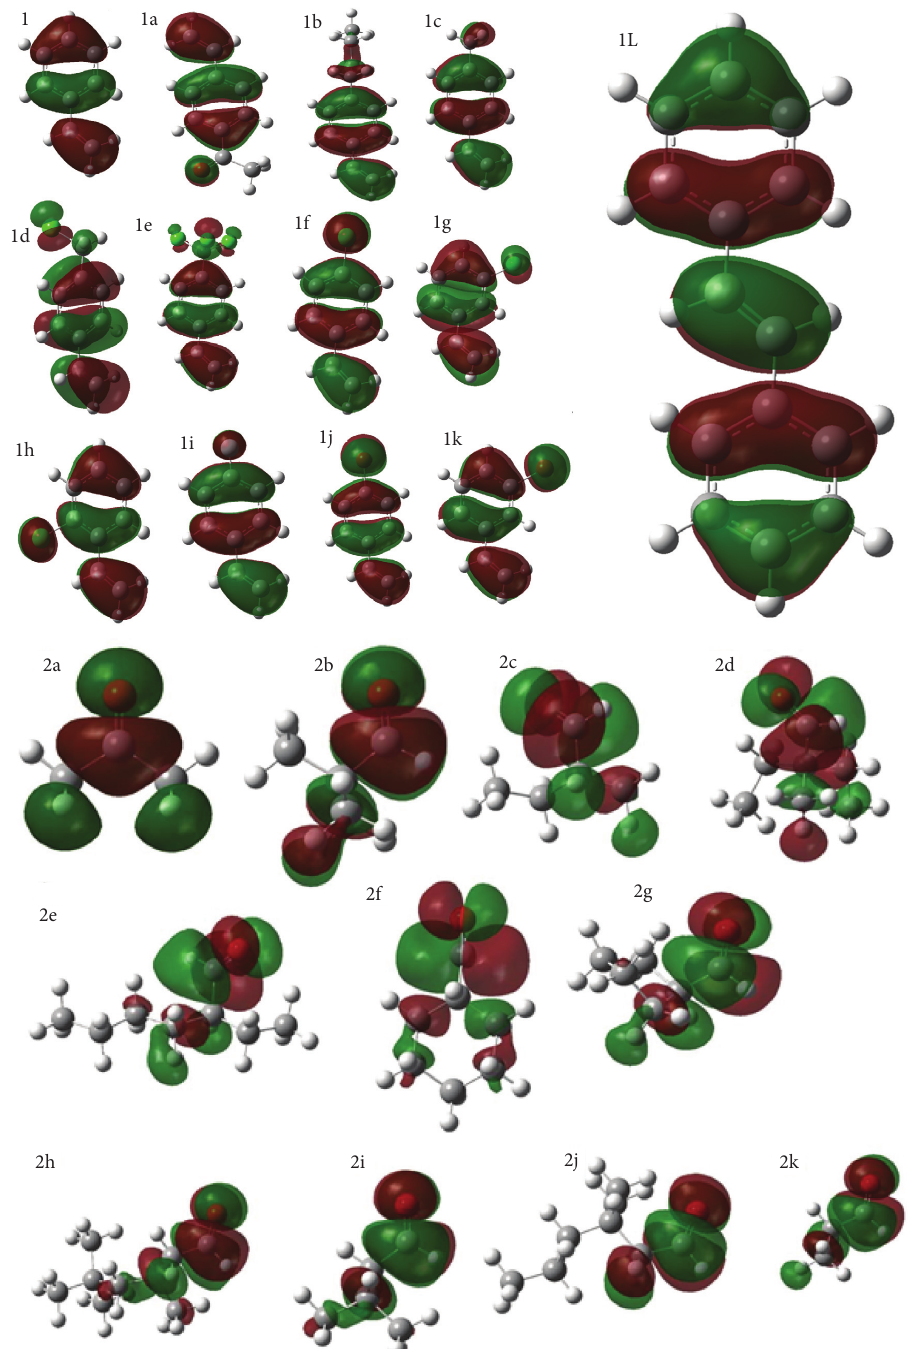
Figure 4: Atomic orbitals HOMO of styrene derivative (1a–1m) and atomic orbitals LUMO of aldehyde